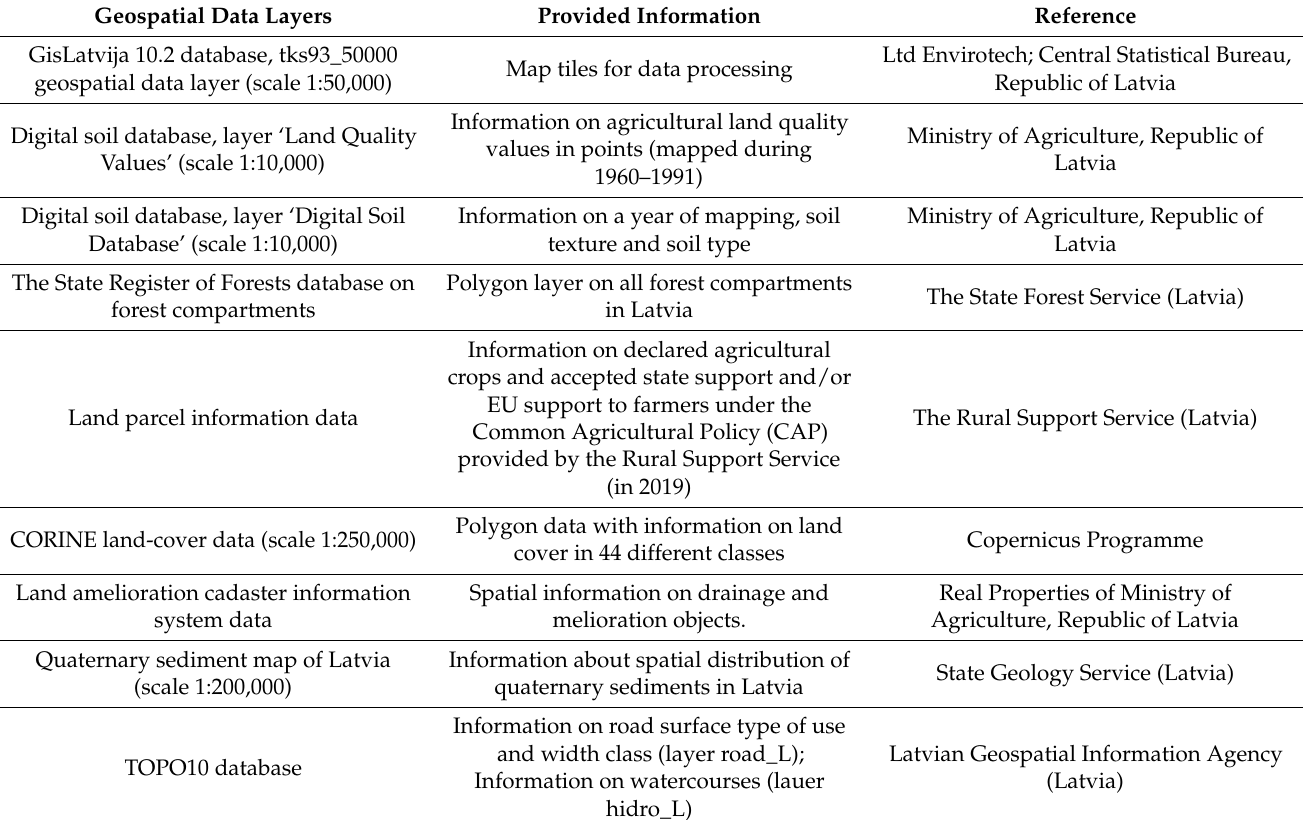
Figure 2. Concept for selecting and characterizing agricultural land parcels suitable for agroforestry (target region) in Latvia (spatial-data-processing framework). Table 1. Geospatial data layers used to select and characterize agricultural land parcels suitable for agroforestry in Latvia.